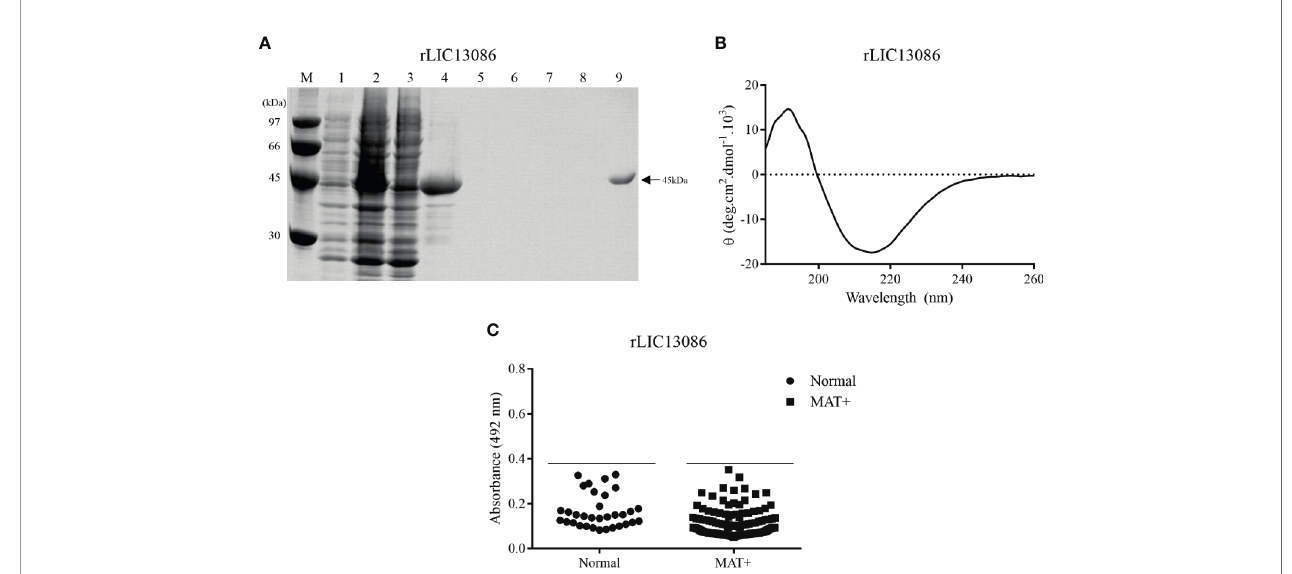
FIGURE 2 | Analysis of rLIC13086 by SDS-PAGE, CD Spectroscopy, and serum reactivity with serum of con fi rmed leptospirosis. (A) Recombinant protein puri fi cation samples were separated by SDS-PAGE (12%) and stained with Comassie Blue. M: molecular weight LMW (Ge Healthcare), (1) non-induced total lysates, (2) induced total lysates, (3) induced soluble fraction, (4) induced insoluble fraction, (5 – 8) washing steps with imidazole (5, 20, 40, and 60 mM), and (9) puri fi ed protein after elution. (B) CD spectra was recorded as accumulative of 10 scans from 260 – 190 nm at 25°C and data are expressed in molar residual ellipticity. (C) The recombinant protein was immobilized onto ELISA plates (250 ng/well), and the reactivity was assessed by total IgG antibodies in sera from leptospirosis patients at convalescent phase (MAT+) and detection with incubation of HRP-conjugated anti-human IgG (1:5,000). The cutoff values are represented by the horizontal line and de fi ned as the mean plus three standard deviation of the absorbances values from normal human serum